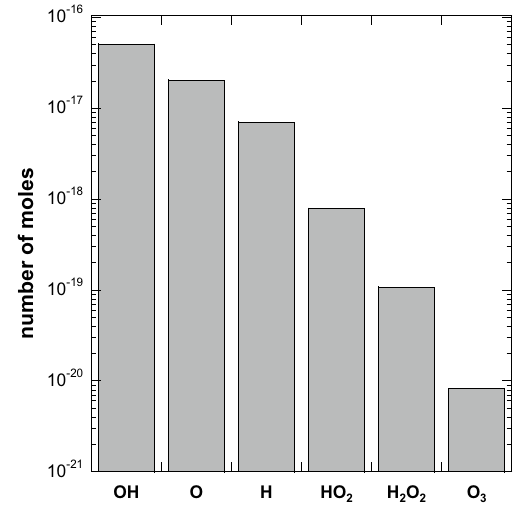
Fig. 4 Bubble yield ( hydroxyl radical) as function of the maximum bubble temperature and pressure reached at the collapse for all the interval of active bubbles (conditions—ambient bubble radius: 0.2–3 µm, liquid temperature: 25 °C, static pressure: 1 atm, fre- quency: 1700 kHz, power: 15 W)